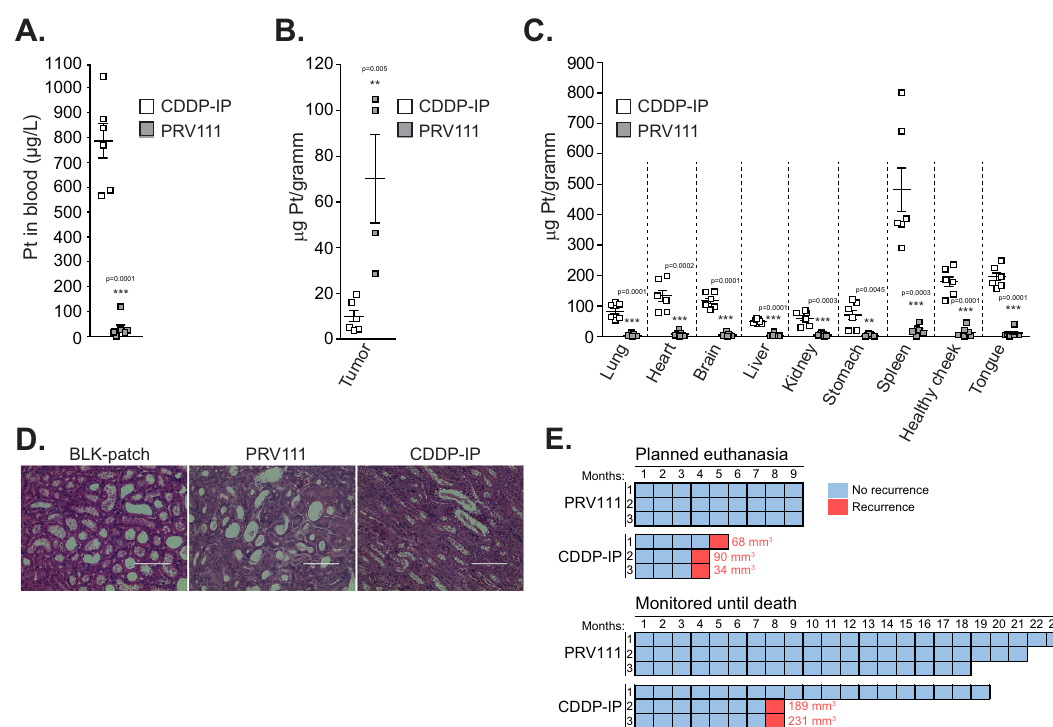
Fig. 3 Topical administration of PRV111 reduced cisplatin associated toxicities and prevented tumor recurrence in vivo. A Blood was collected after administration of the fi rst dose of CDDP-IP or PRV111 (6 animals per group), and level of cisplatin was quanti fi ed by ICP-MS, shown as average ± SEM ( p = 0.0001; Student ’ s unpaired t -test). B , C Hamsters treated with CDDP-IP or PRV111 (6 animals per group) were sacri fi ced and residual tumors as well as lungs, heart, brain, liver, kidneys, stomach, spleen, healthy contralateral cheek pouch, and tongue were harvested. Samples were weighted, processed, and biodistribution of cisplatin was assessed by ICP-MS, shown as average ± SEM ( p = 0.005 for tumor tissue all body organs analyzed; Student ’ s unpaired t-test). Note, residual tumors were collected from four animals treated with PRV111. D Representative H&E stained histopathological images of kidneys (×200; scale bar — 100 μ m). Three tumors per group were stained. E Animals that were tumor free after treatment with either PRV111 or CDDP-IP (6 per group) were monitored for recurrence and survival during the indicated time period (months) post treatment cessation. Animals were evaluated and weighted weekly until day 45, and once a month thereafter. Cyan squares indicate a month when animal remained tumor-free. Pink squares indicate a month when recurrence was detected. Tumor volume upon recurrence is provided next to the each pink square. Source data are provided as a Source Data fi